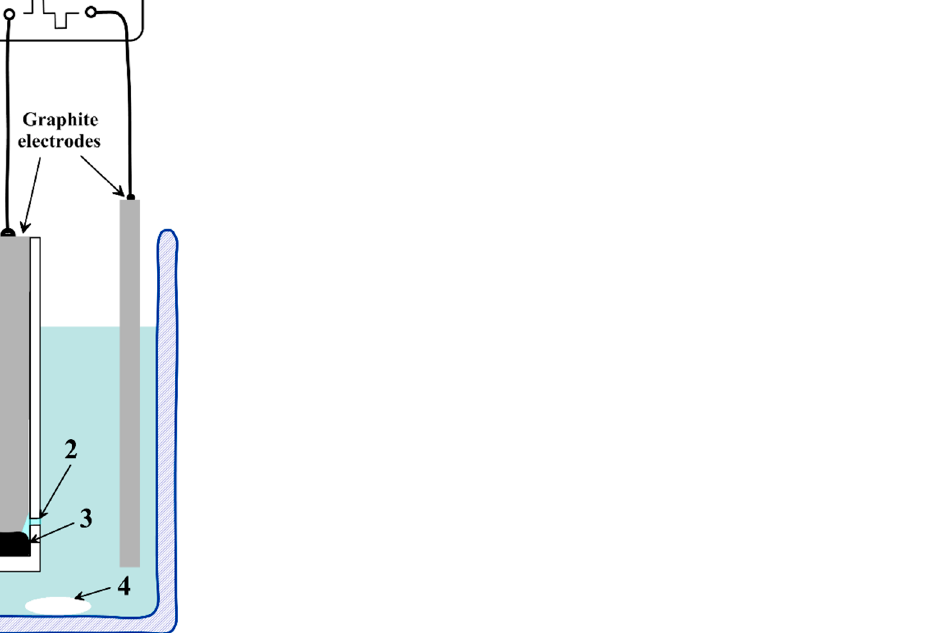
Figure 1. Schematic diagram of the reactor and cell configuration for the high-voltage pulse exfoliation of black phosphorus and graphite: 1—the source of high-voltage impulses, 2—holes for electrolyte, 3—black phosphorus, 4—magnetic stirrer, and 5—Teflon reactor.